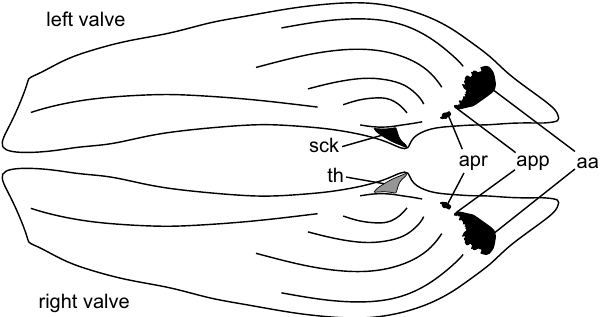
Fig. 6. Drawing of the pachydomid bivalve Leinzia similis (Holdhaus, 1918) (sensu stricto) showing the general morphology. The hinge area and anterior muscles scars are highlighted. Abbreviations: aa, anterior adductor muscle scar; app, anterior pedal protractor muscle scar; apr, anterior pedal retractor muscle scar; sck, socket; th,